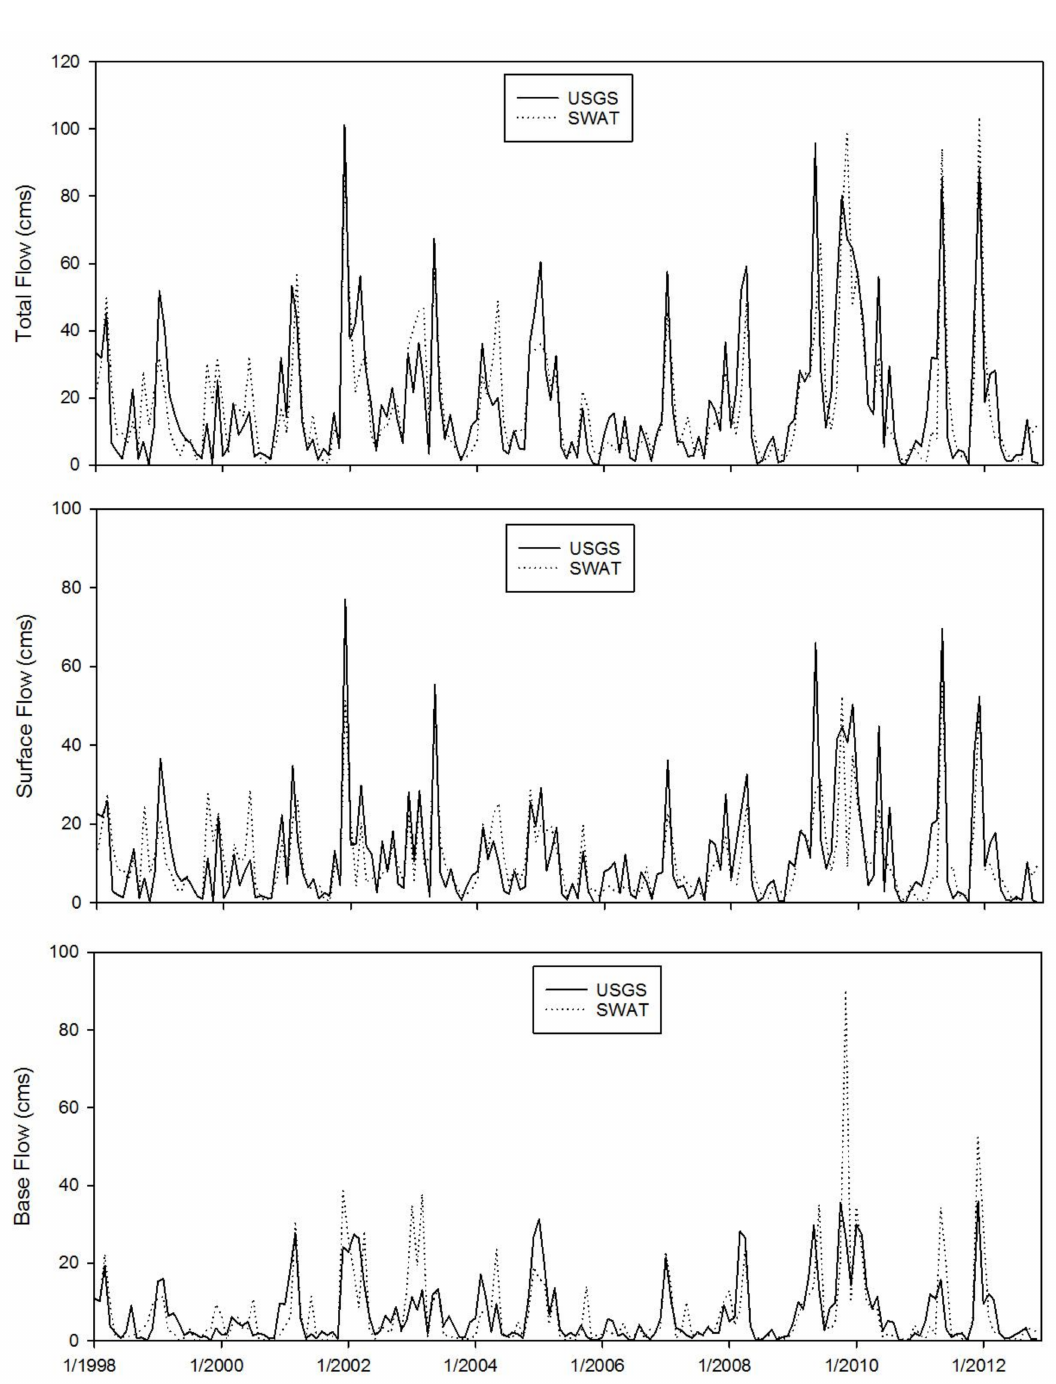
Figure 3. Graphical comparison of the USGS (measured) and SWAT (simulated) flow data at the Colt